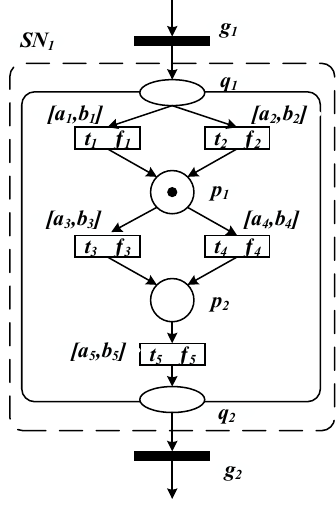
Figure 2. An example of OOPRES+